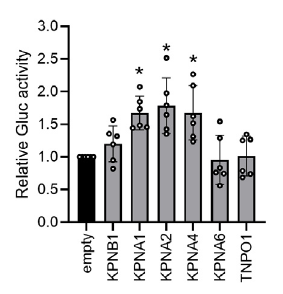
Figure 6. Avian importin α proteins increase the polymerase activity of the PaBV-4 minireplicon in mammalian cells. 293T cells were co-transfected with expression plasmids encoding the PaBV-4 N, P, and L proteins and the indicated chicken importin proteins. Gluc activity was measured 72 h post transfection and was normalized to WST-1 activity. The relative ratios of Gluc activity in the cells transfected with importin plasmids to those with pcDNA3 empty plasmid are shown. Each dot represents the relative ratio of an independent experiment. The data are presented as the means and + SEs of results from six independent experiments. One-way ANOVA followed by a Dunnett’s test was used for statistical analysis. *, p <